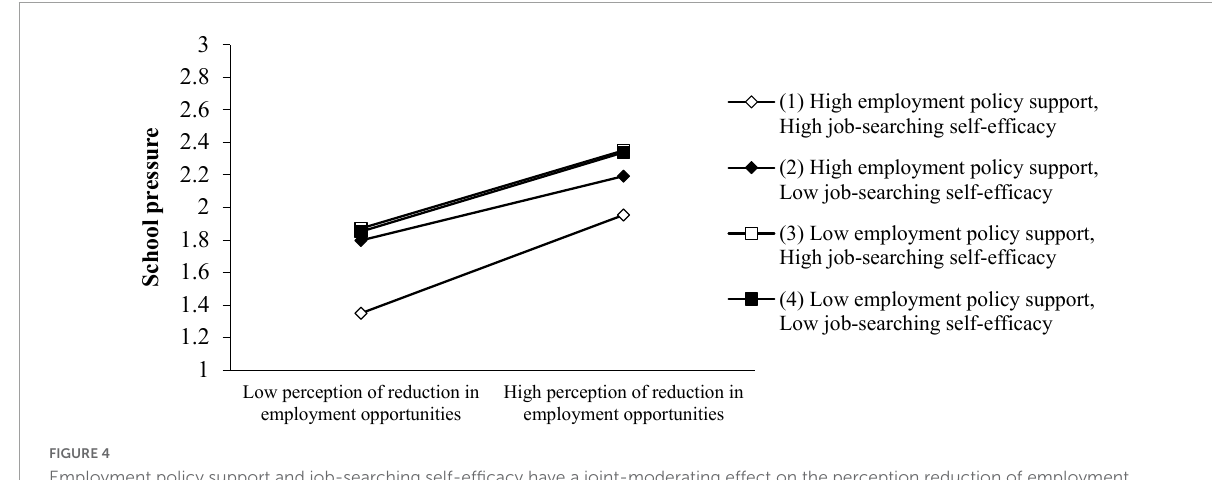
FIGURE4 Employment policy support and job-searching self-efficacy have a joint-moderating effect on the perception reduction of employment opportunities and college students’ school pressure.